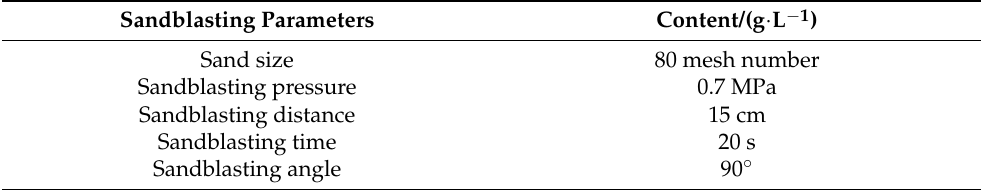
Table 2. Sandblasting pretreatment parameters.